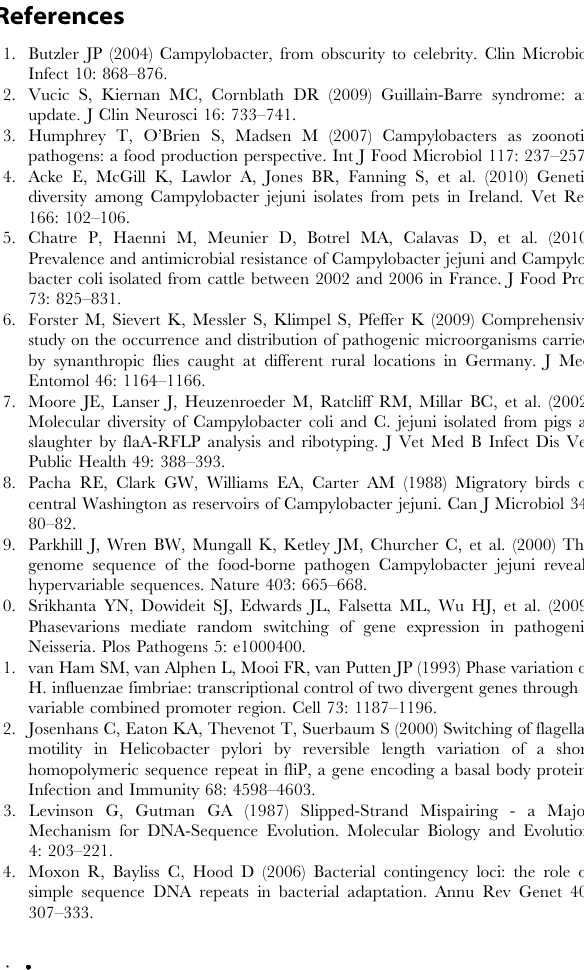
Table S2 Consensus mutations in our NCTC11168 (ATCC 700819) culture. These mutations were found through mapping to the reference genome sequence (GenBank AL111168.1), and analysis as described in the Methods.